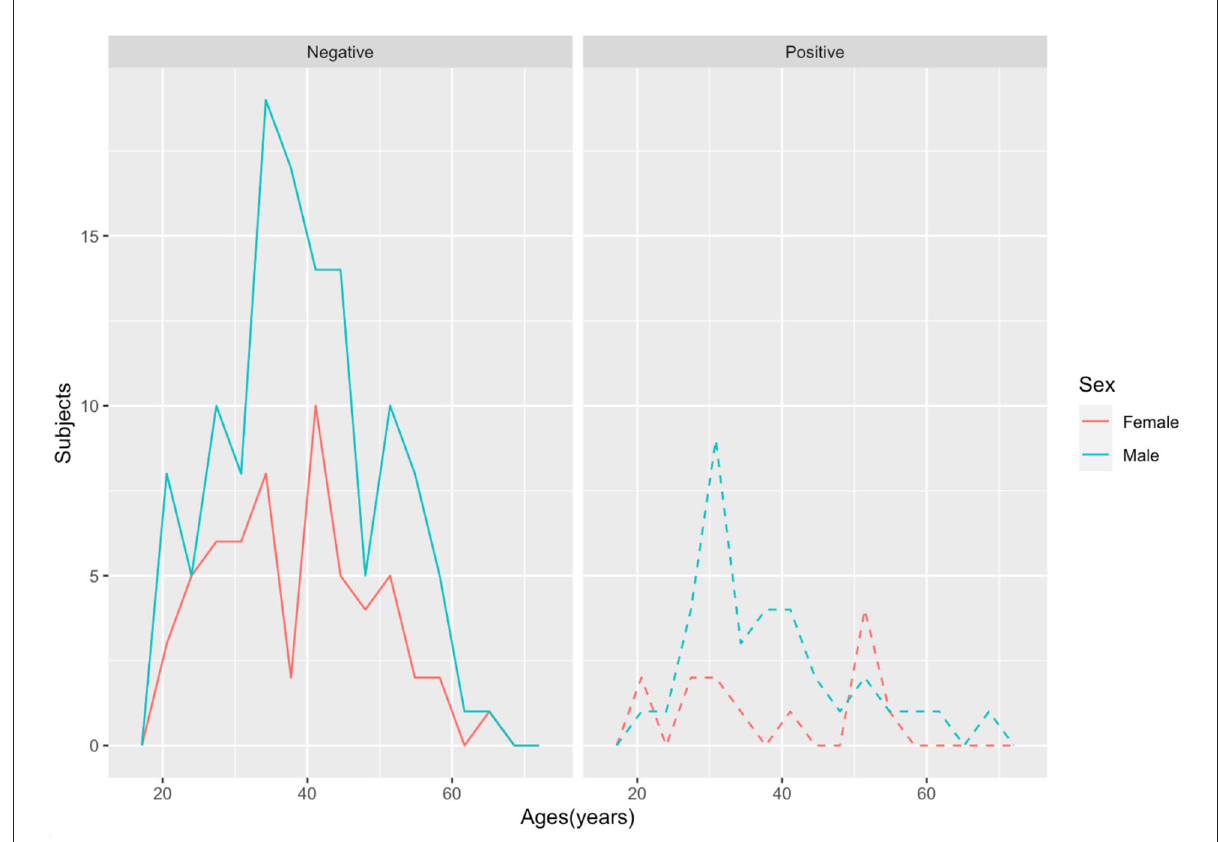
FIGURE1 Age and sex distribution of SARS-CoV-2 test positivity among the 232 mortuaries’